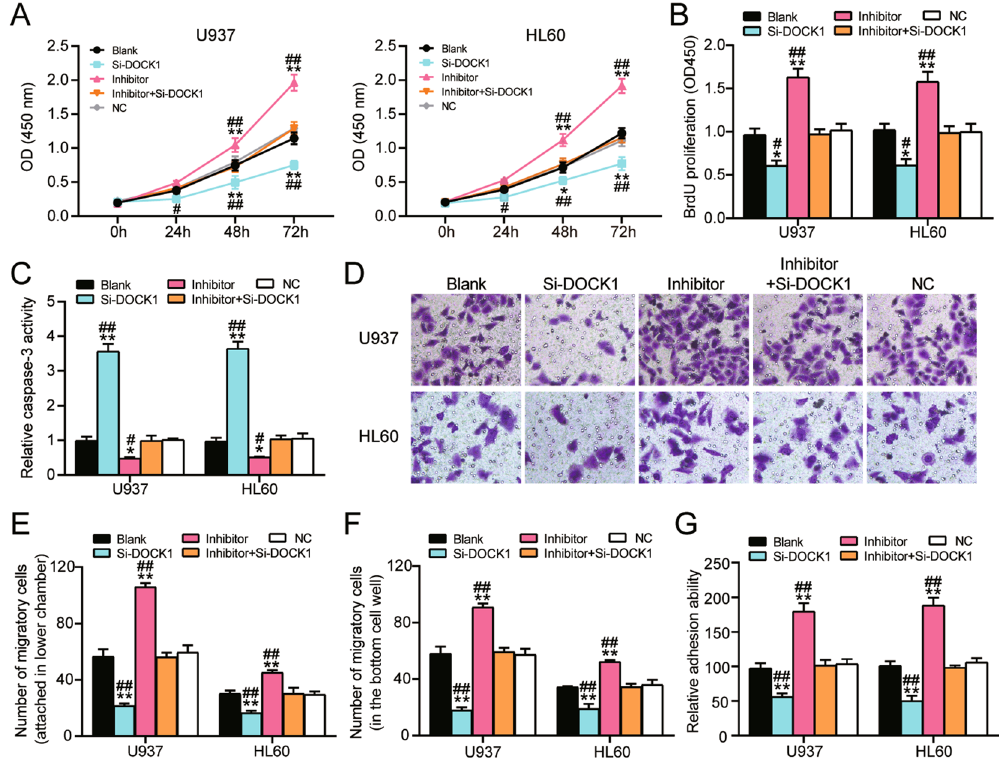
Figure 5. MiR-4458 exerts its accelerative effect on AML cells proliferation, migration, adhesion and restrictive effect on cell apoptosis through the regulation of DOCK1. ( A ) CCK-8 assay was conducted to evaluate the cell viability of U937 and HL60 cells transfected with DOCK1 siRNA (si-DOCK1), miR-4458 inhibitor (inhibitor), DOCK1 siRNA and miR-4458 inhibitor (inhibitor + si-DOCK1), negative control (NC) or cells with no treatment (Blank) after culture for 0 h, 24 h, 48 h, 72 h. ( B ) BrdU assay was performed to determine the proliferative capacity of U937 and HL60 cells in the above groups. ( C ) Caspase-3 activity was evaluated to reflect the apoptosis of U937 and HL60 cells in the above groups. ( D – F ) The migration ability of U937 and HL60 cells in the above groups was evaluated by transwell assay. ( D ) Representative picture and ( E ) Statistical analysis of migratory cells attached in the bottom chamber. ( F ) Statistical analysis of migratory cells migrated into the culture medium of lower cell well. ( G ) The cell adhesion capacity of U937 and HL60 cells in the above groups was analyzed by cell adhesion assay. Three biological repeats were performed for each experiment, and the data were shown as mean ± SD. Statistics analysis was carried out with Student’s t -test or one-way ANOVA. * P < 0.05; ** P < 0.001 versus Blank group; # P < 0.05; ## P < 0.001 versus inhibitor + si-DOCK1